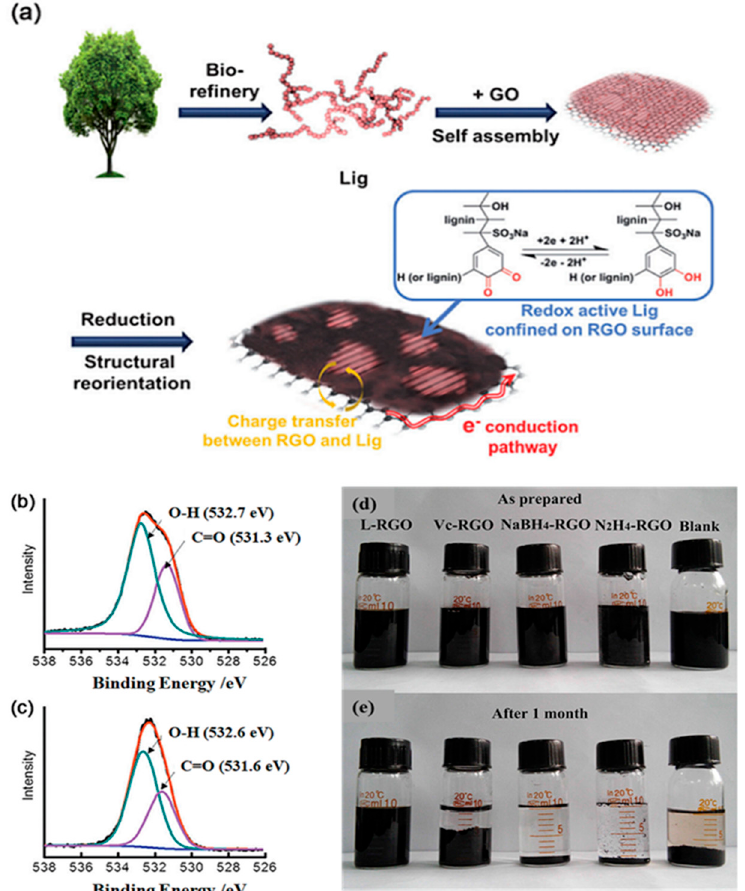
Figure 3. ( a ) Mechanism of energy-storage in RL composites derived from natural polymers. ( b , c ) High-resolution O 1s XPS spectra of RL-60 recorded ( b ) before and ( c ) after charging. Reprinted with permission from Ref. [30]. Copyright 2014 John Wiley & Sons. ( d , e ) Photographs of RGO dispersions treated with various reducing agents: ( d ) as-prepared and ( e ) after 1 month. Reprinted with permission from Ref. [32]. Copyright 2017 Elsevier.